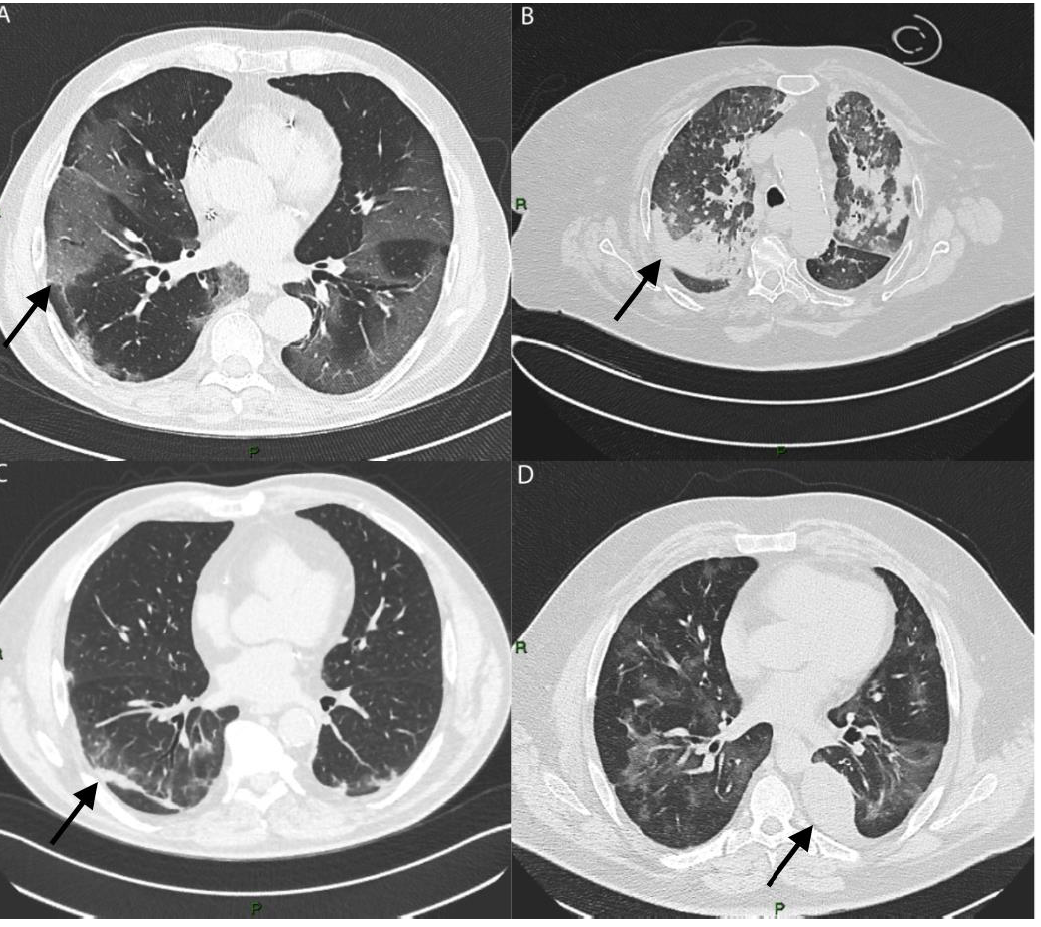
Figure 2. Axial images of different evaluated patterns of COVID-19 (each marked with arrow keys): ( A ) bilateral ground glass (GGOs); ( B ) consolidation; ( C ) subpleural bands; ( D ) pleural effusion.